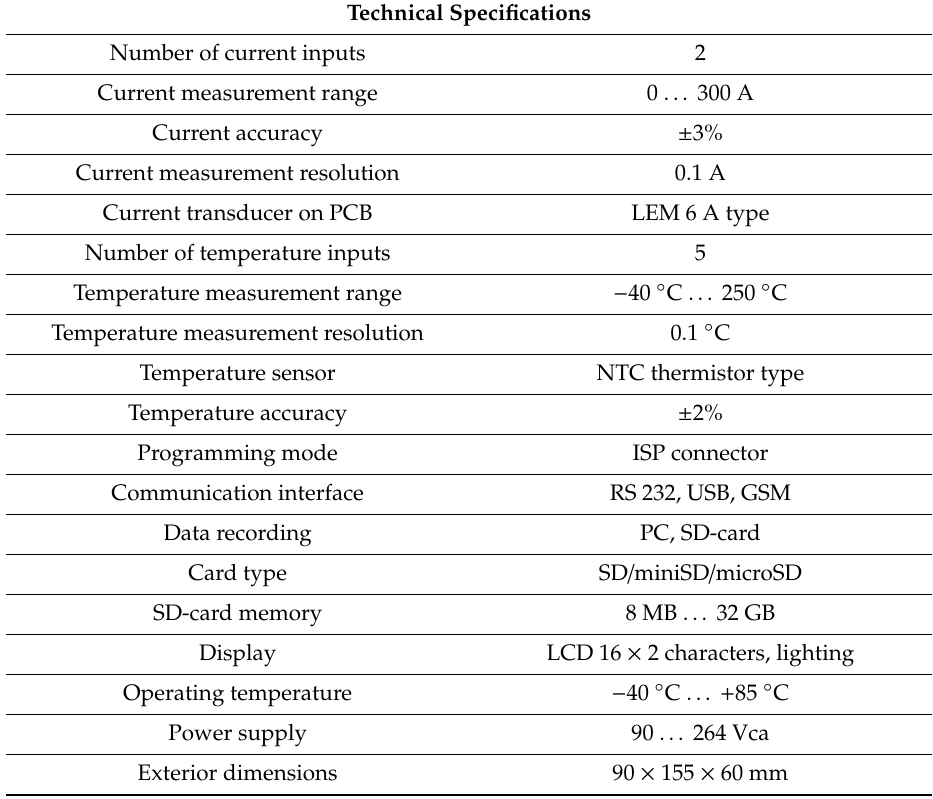
Table 2. Technical specifications of the impedance bond monitoring and diagnosis